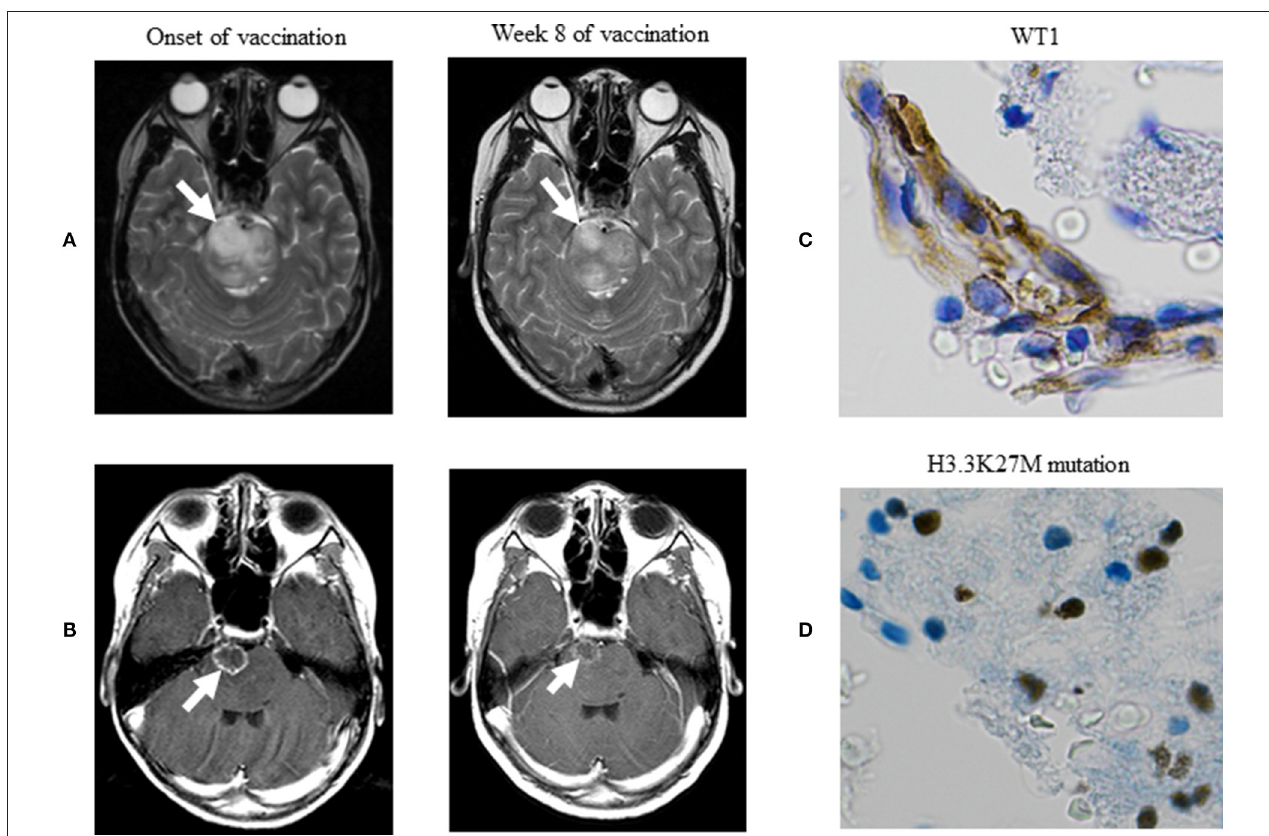
FIGURE 1 | MRI of DMG. (A) Axial T2-weighted MR images. (B) Axial T1-weighted postcontrast MR images. These images demonstrate a well-circumscribed mass (arrows), and best response among responses assessed with the Response Assessment in Neuro-Oncology criteria was stable disease. (C) Immunohistochemical stain demonstrating WT1 protein in the nucleus and cytoplasm of tumor cells, with greater staining intensity in the cytoplasm—a previously known histopathological feature for primary astrocytic tumors ( × 400). (D) Immunohistochemical stain demonstrating the H3.3K27M mutation in the nucleus of tumor cells, displaying highly anaplastic, pleomorphic tumor cells with abnormal nuclear morphology—histopathological evidence supporting the diagnosis of histological grade IV glioma ( × 400). MRI, magnetic resonance imaging; DMG, diffuse midline glioma; RANO, response assessment in